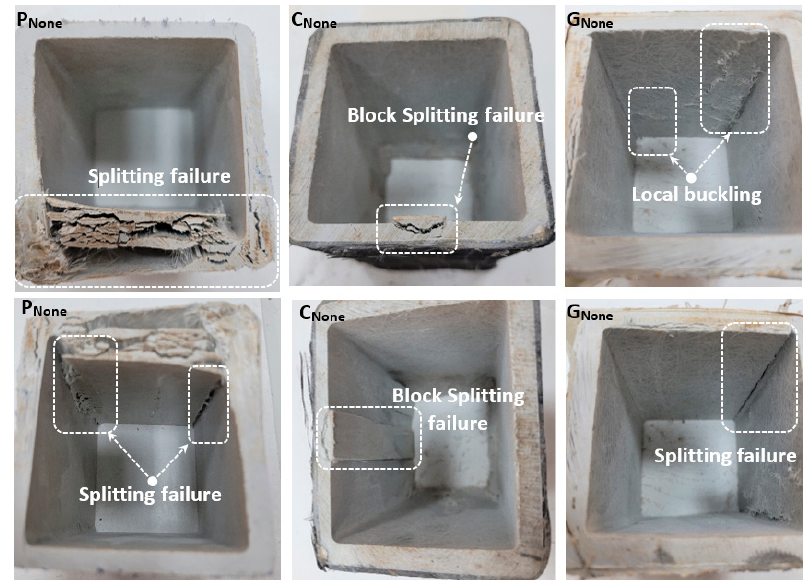
Figure 3. Damage analyses of P None , C None , G None .